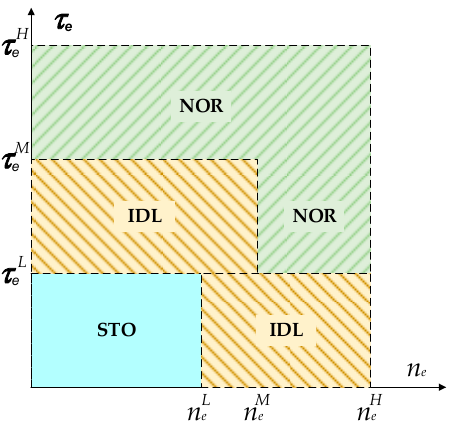
Figure 7. ICE working regions to define ICE modes.